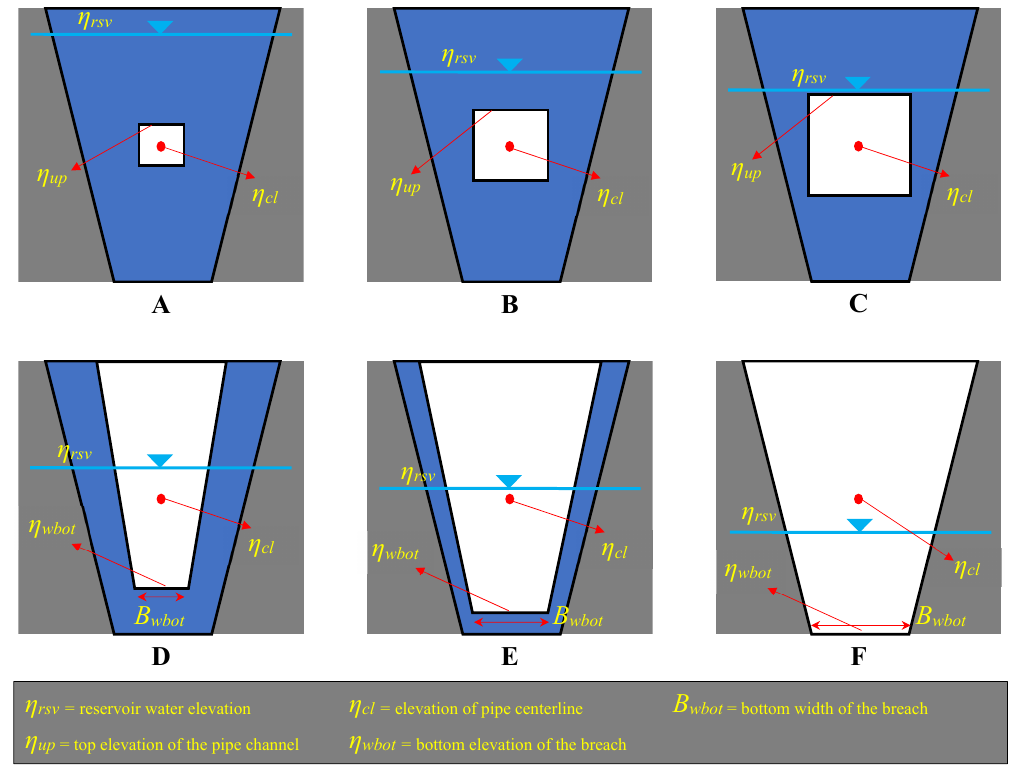
Figure 7. Piping mechanism: from orifice to weir